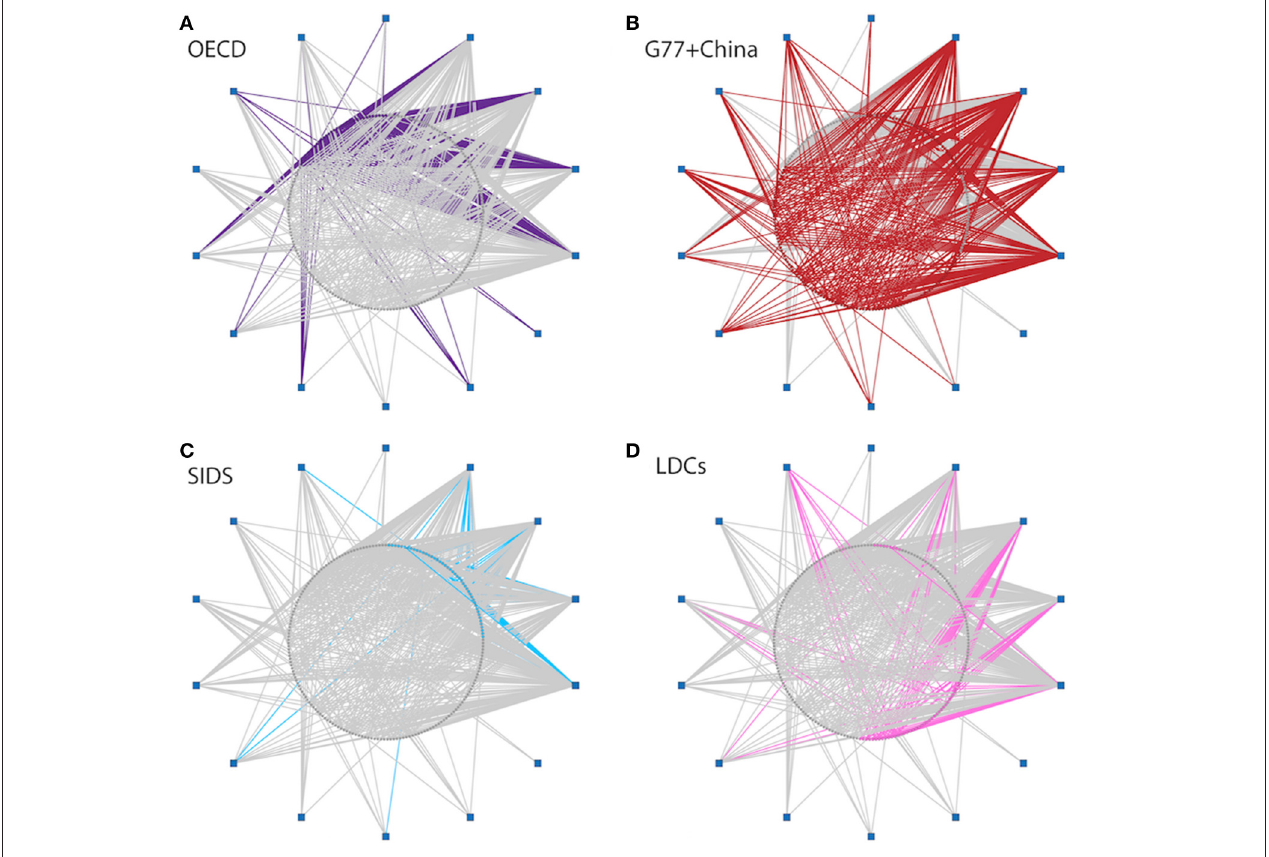
FIGURE 1 | Network diagrams showing countries’ (circles) participation in meetings related to biodiversity in areas beyond national jurisdiction (squares). The diagrams are colored to highlight participation by (A) Organization for Economic Cooperation and Development (OECD) members, (B) Group of 77 + China members (G77 + China), (C) small island developing states (SIDS), and (D) least developed countries (LDCs). [Note, there are 34 OECD members, 134 G77 + China members, 52 SIDS, and 48